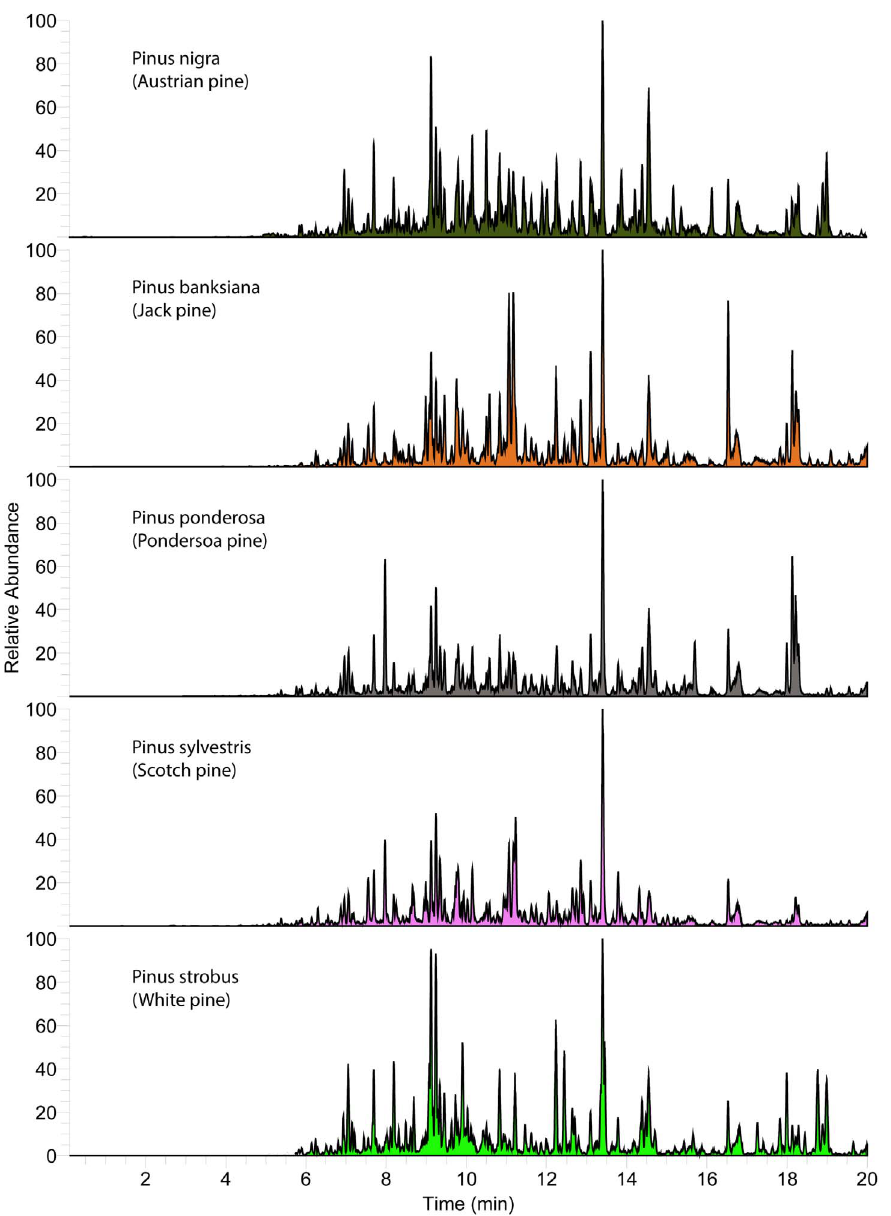
Figure 3. Resin metabolite diversity of studied Pinussp . (Pine). Base-peak negative-ion chromatogram (‘‘fingerprints’’) of resin collected from individual Pinus spp . within 2 miles of the study apiary.